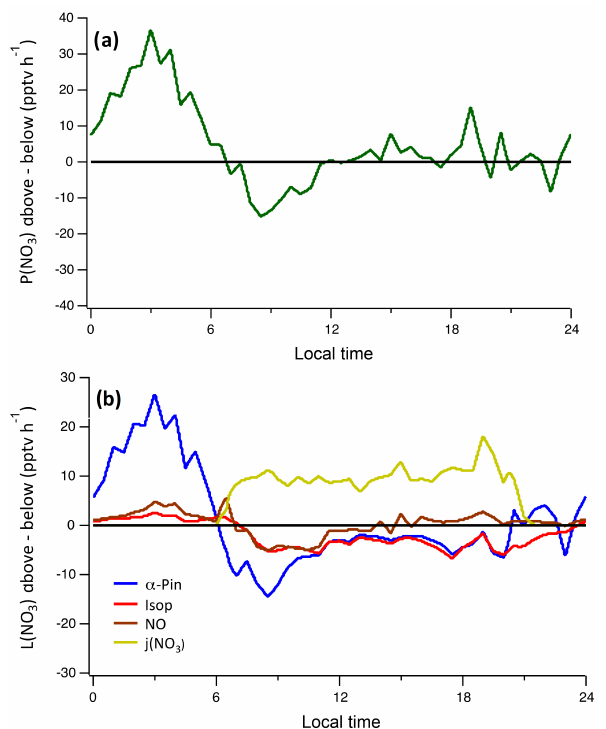
Figure 2. (a) Difference in the NO 3 production rate ( P (NO 3 )) above and below the forest canopy. (b) Difference in individual NO 3 loss rates ( L (NO 3 )) from photolysis, reaction with NO, oxi- dation of isoprene, and oxidation of α -pinene above and below the forest